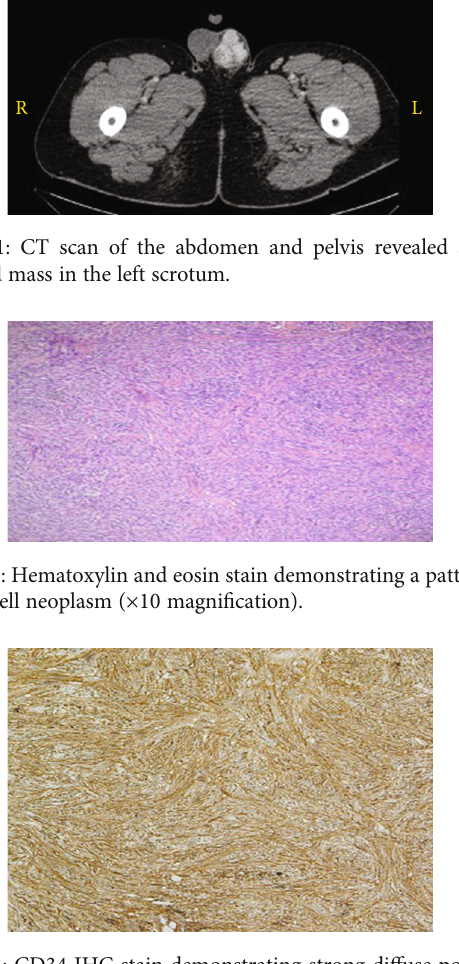
Figure 3: CD34 IHC stain demonstrating strong di ff use positivity ( × 10 magni fi cation).